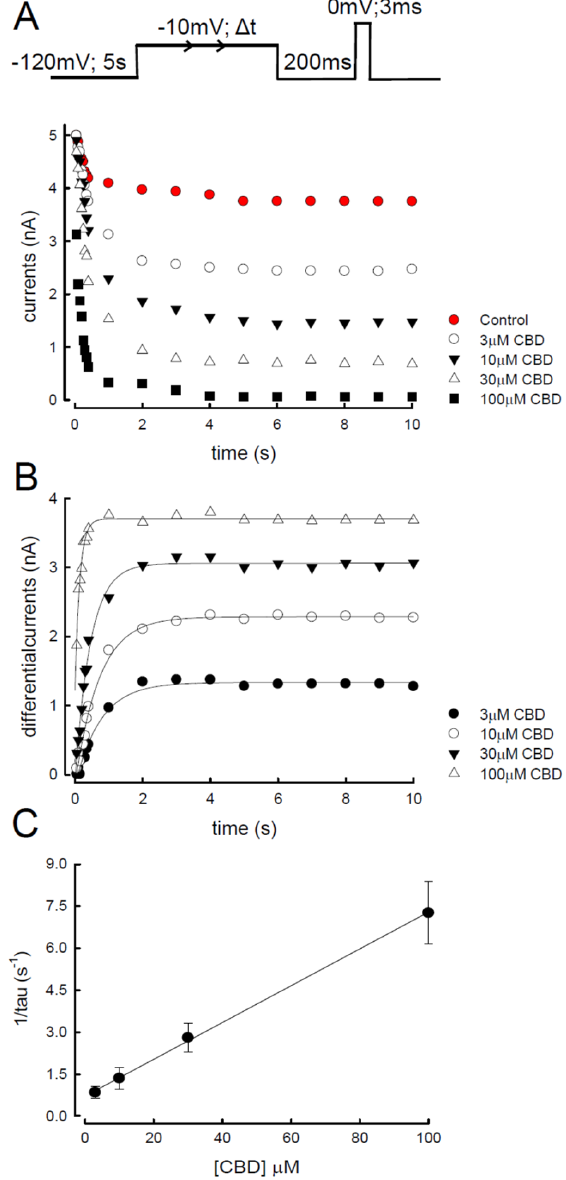
Figure 6. Binding rate of cannabidiol to the slow-inactivated Na v 1.4 channel. ( A ) Patched cells were held at − 120 mV for 5 s and stepped to an inactivating pulse at − 10 mV for various durations of time (0.05, 0.1, 0.15, 0.2, 0.25, 0.3, 0.35, 0.4, 1, 2, 4, 5, 6, 7, 8, 9, and 10 s). The cells were then subjected to a fixed gap at − 120 mV for 200 ms, which was set to allow for partial recovery of the slow-inactivated channels to obtain measurable currents elicited by the subsequent test pulse at 0 mV. Elicited currents were plotted against the duration of the inactivating pulse ( − 10 mV), and the representative currents were overlaid according to the time sequence. ( B ) Differential currents between the CBD and control conditions. Data were obtained from Figure 6A and are plotted against the duration of the prepulse. The time constants from the fit were 801.3, 740.2, 454.5, and 138.7 ms for the different CBD concentrations, namely, 3, 10, 30, and 100 µ M, respectively. ( C ) The reciprocal of the time constant from that fitted in Figure 6B is plotted against the concentrations of CBD. The slope of the solid line is 64,000 M − 1 s − 1 , and the y-intercept is 0.7 s − 1